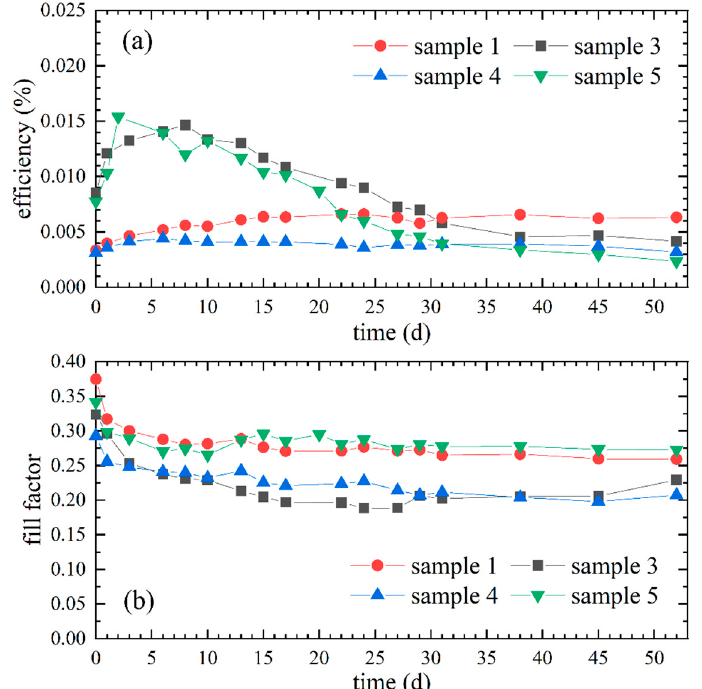
Figure 4. Comparison of samples 1 and 3 to 5 with regard to the potential influence of the PEO concentration in the gel electrolyte with 8 wt% in sample 5, 9.5 wt% in sample 3, 17.4 wt% in sample 1 and 24.0 wt% in sample 4: ( a ) Temporal progressions of the efficiencies of the corresponding samples; ( b ) Illustration of the respective fill factors over time.